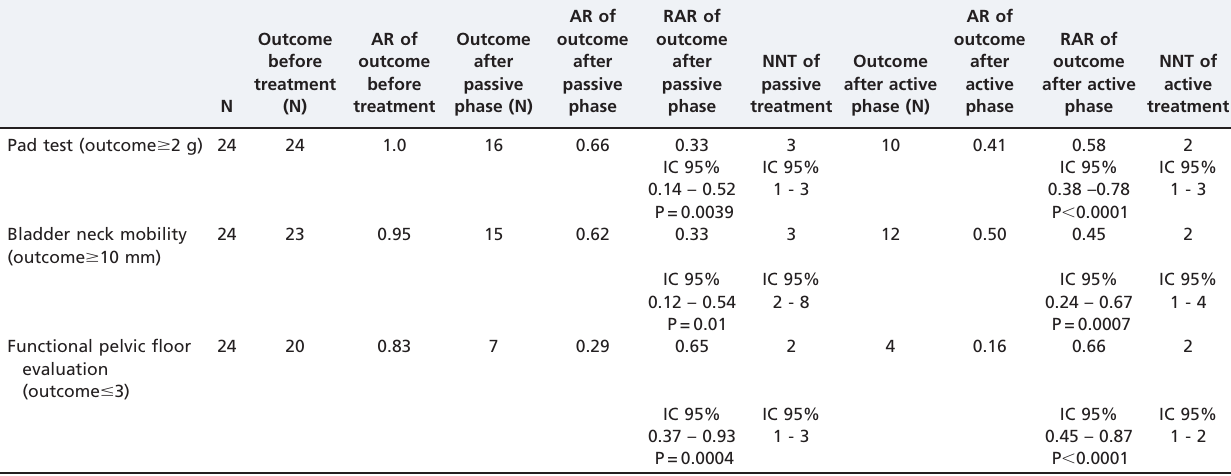
Table 2 - An intention-to-treat analysis of the pad test, the bladder neck mobility and the functional pelvic floor evaluation at baseline and at the end of the passive and active phases.